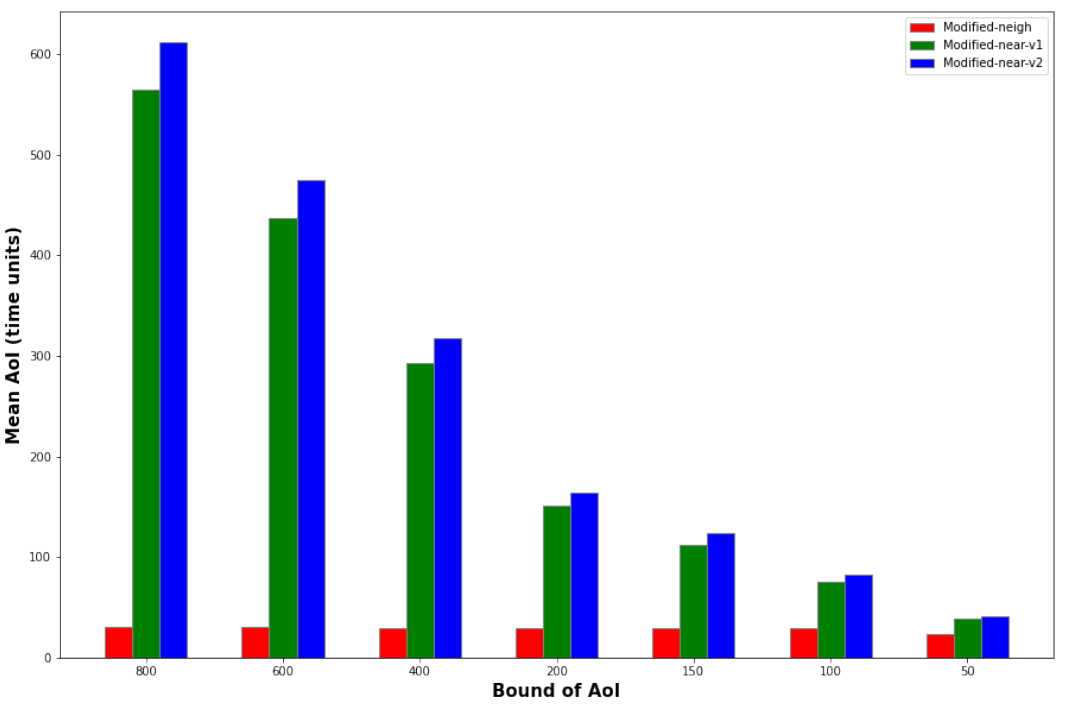
Figure 10. Dependence of AoI versus Bound of AoI for Modified-neigh, Modified-near-v1 and Modified-near-v2